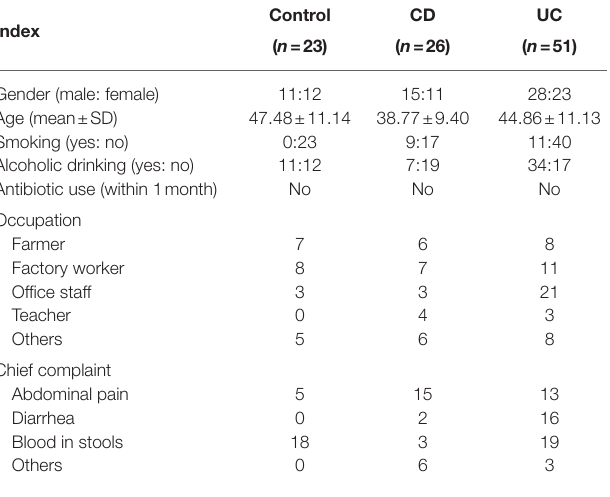
TABLE 1 | Basic characteristics of all IBD